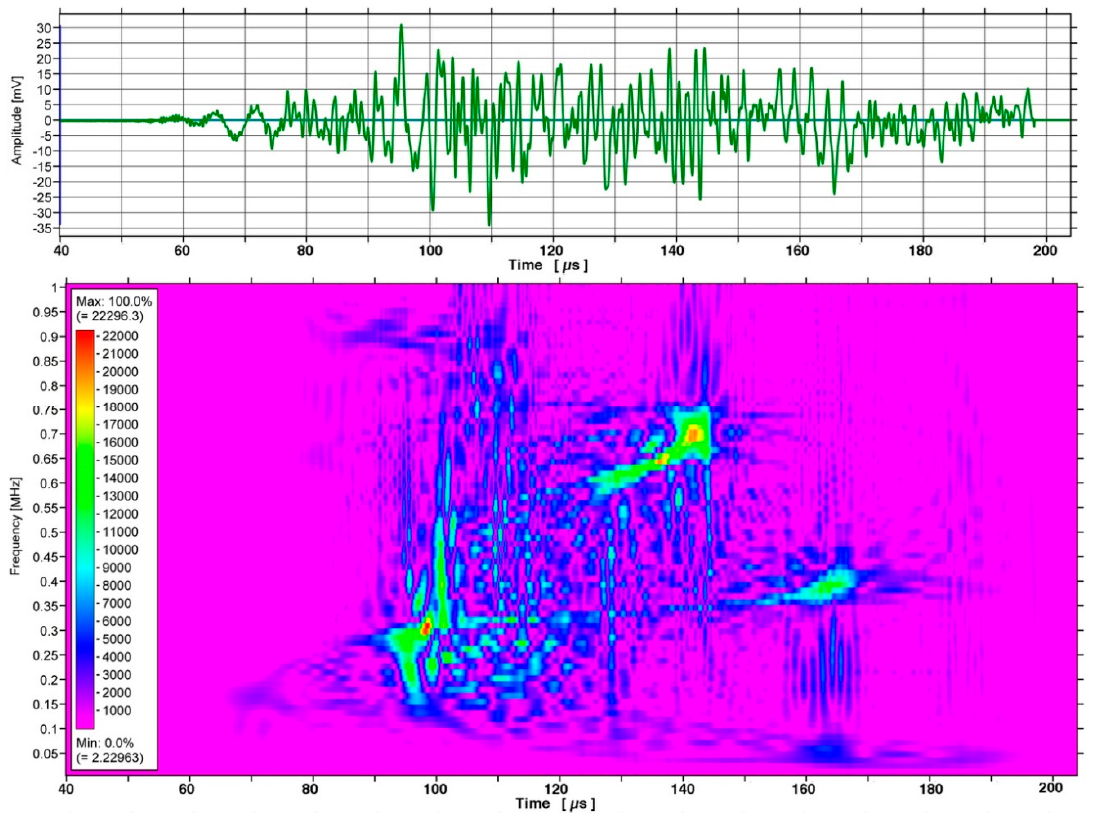
Figure A7. Output waveform of a KRN sensor without FET buffer (#12035) from asymmetric excitation method and its CWT spectrogram for 40–200 µs segment up to 1 MHz. Notice much lower intensities below 100 kHz in comparison to Figure A3.